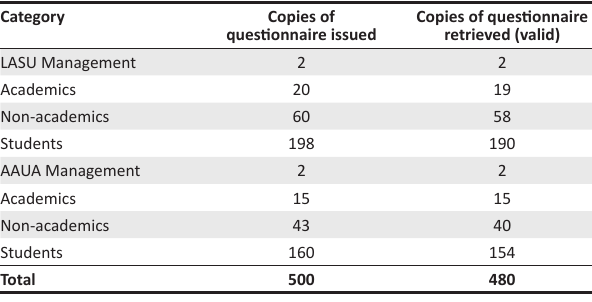
TABLE 2: Questionnaire